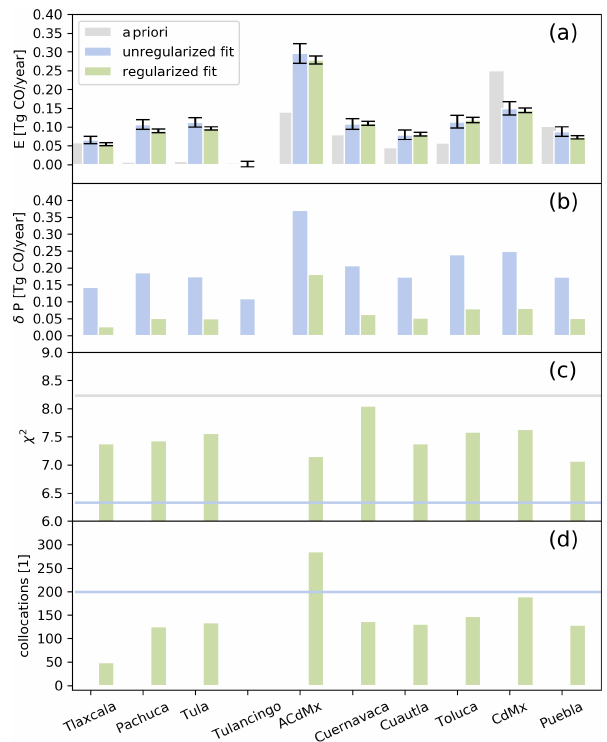
Figure 5. Statistics of CO emissions averaged from 9 Novem- ber 2017 to 25 August 2019 for the tracer domains shown in Fig. 1. (a) Median of the a priori emissions (adapted INEM inventory) used for the WRF-Chem simulation (grey) and retrieved from the TROPOMI data (unregularized fit in blue, regularized fit in green). The error bars indicate the standard error in the mean calculated from the delta percentiles (b) used as a robust estimation of the standard deviation; (c) the median of the goodness of the fit ( χ 2 ), and (d) the number of collocations. The number of collocations and the χ 2 values of the a priori simulation and unregularized fit are the same for all tracer domains (blue and grey line), but in the fi- nal regularized fit they change due to the information content fil- tering. Here, a collocation corresponds to a specific day because TROPOMI overpasses the region only once.